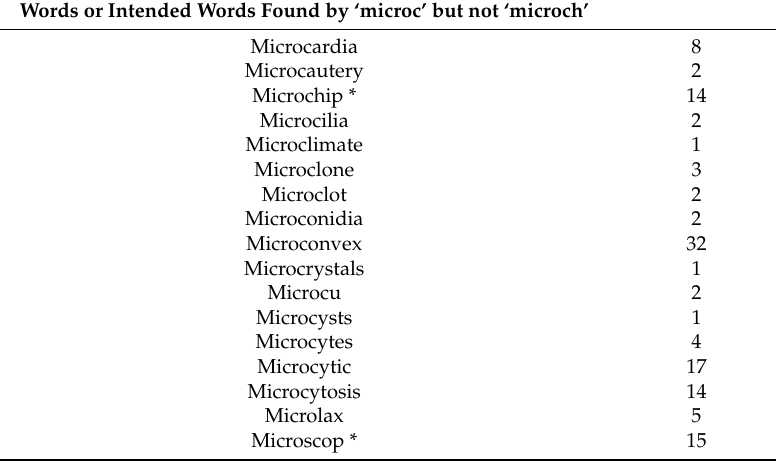
Table 5. Words that were found by searching the 2017 electronic patient records of the VetCompass Australia database using ‘microc’, but not when using ‘microch’.